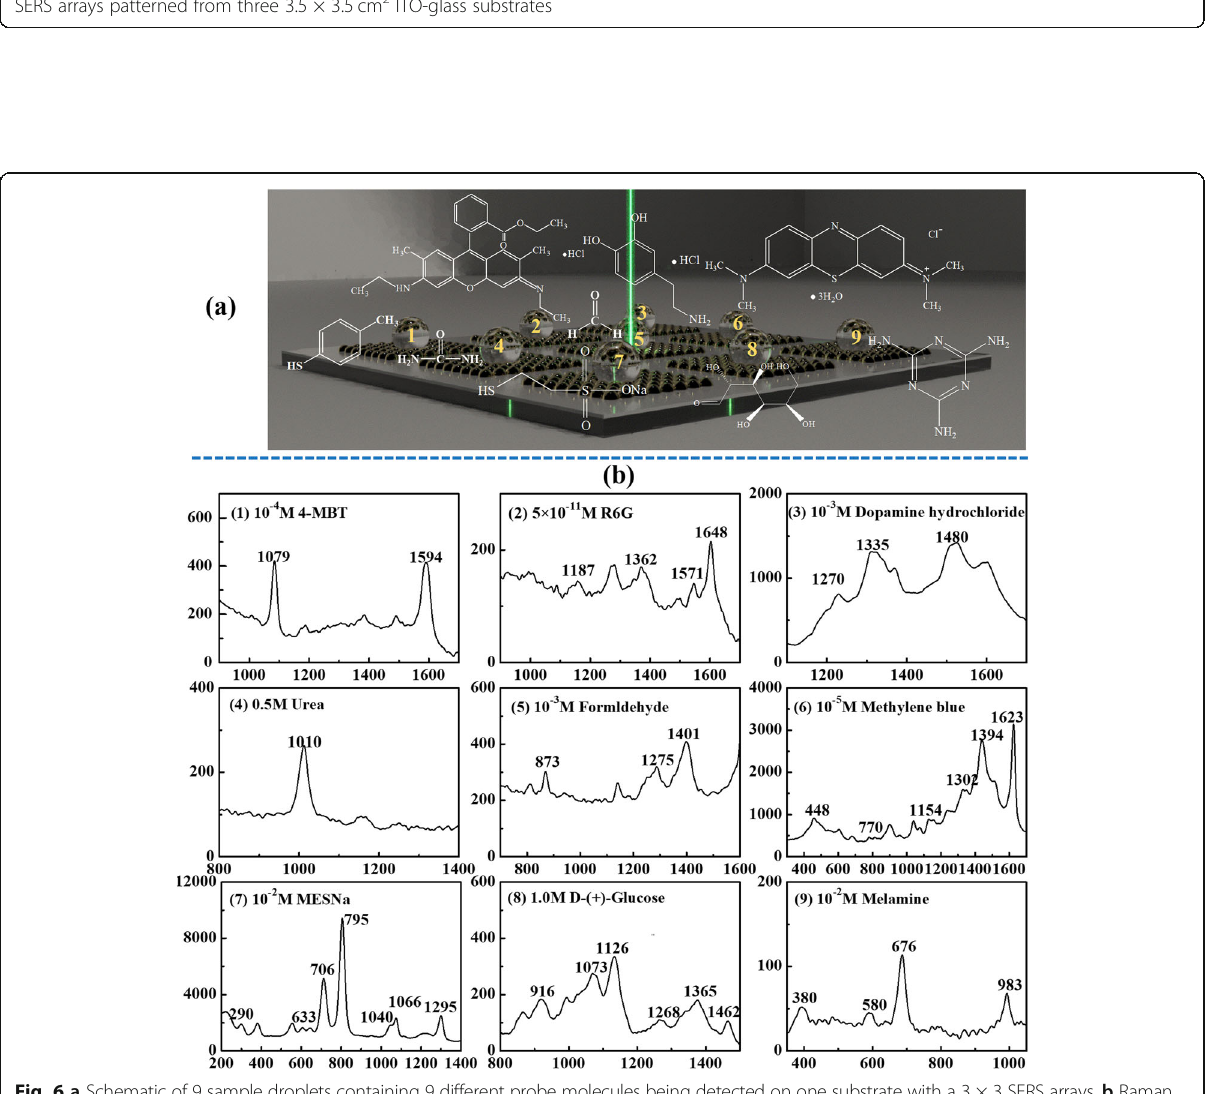
Fig. 6 a Schematic of 9 sample droplets containing 9 different probe molecules being detected on one substrate with a 3 × 3 SERS arrays. b Raman spectra of the 9 probe molecules on each SERS area of the 3 × 3 arrays